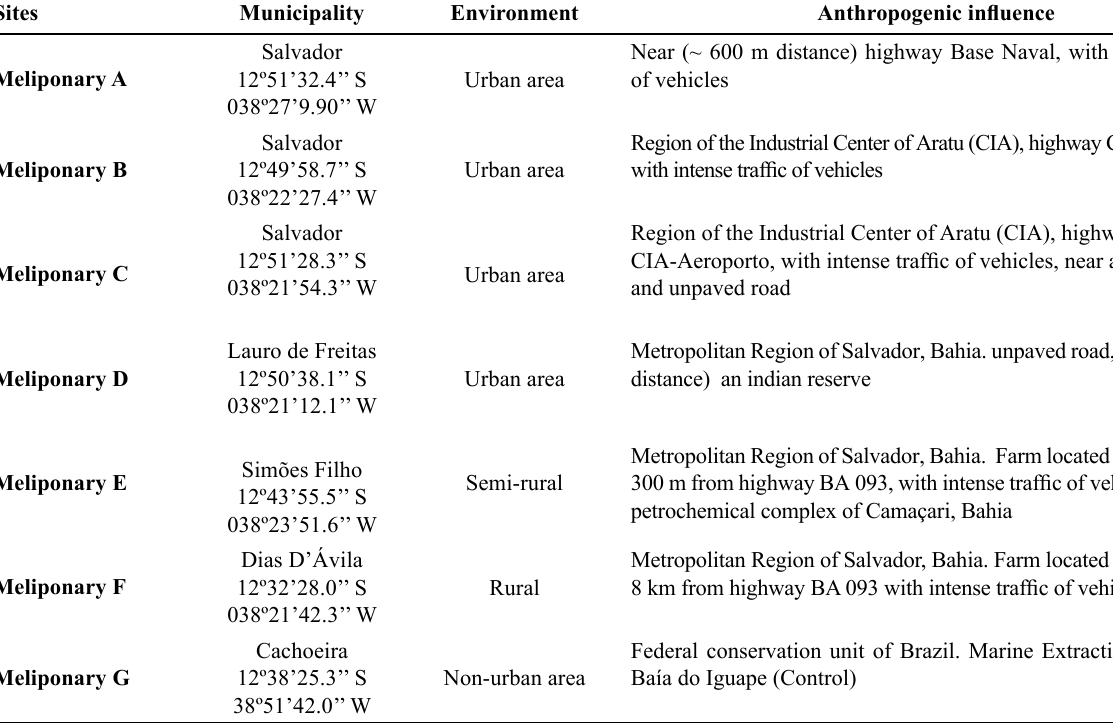
Table 1 . Description of sampling sites in Salvador and the metropolitan region, Bahia,